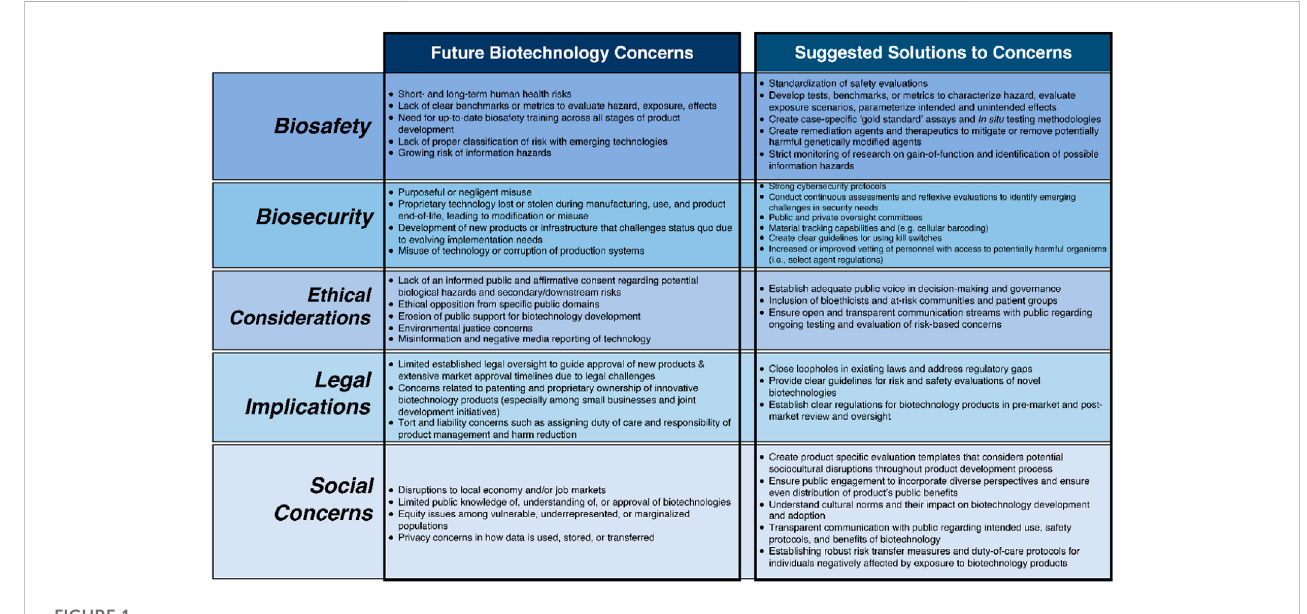
FIGURE 1 Examining ELSI concerns for expected future